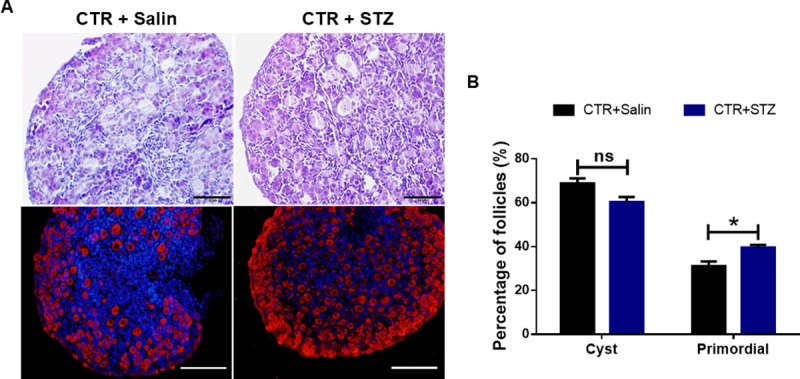
Analysis of follicle development in newborn mice of STZ-induced gestational diabetes.(A) It showed the histological appearance of the newborn mouse ovarian tissue (Scale bars: 50 μm) and ovary whole-mount substratesimmunofluorescence (Scale bars: 100 μm) with MVH antibody in control and STZ-treated groups at PND 1. Oocytes are stained with MVH (red) and Hoechst33342 (blue) to label the nucleus. (B) It showed the percentage of oocytes in cyst and primordial follicle in control and STZ-treated groups at PND 1. At least 5 mice were analyzed in each group; Date are presented as mean ± SEM. *shows a significant difference between STZ-treated and control at P < 0.05; ** shows a significant difference at P < 0.01.